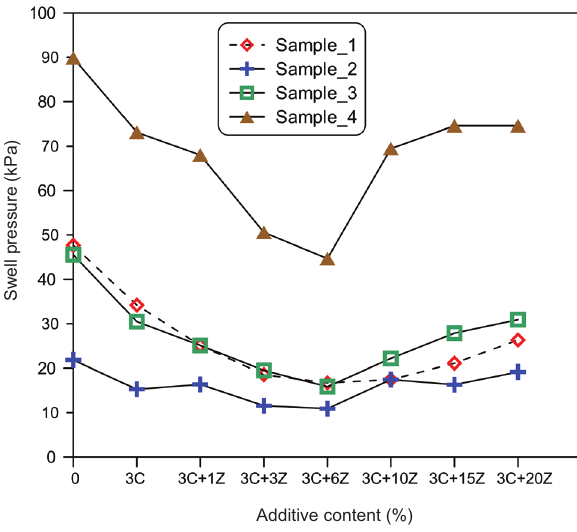
Figure 8 Relationship between additive content and swell pressure of the soil